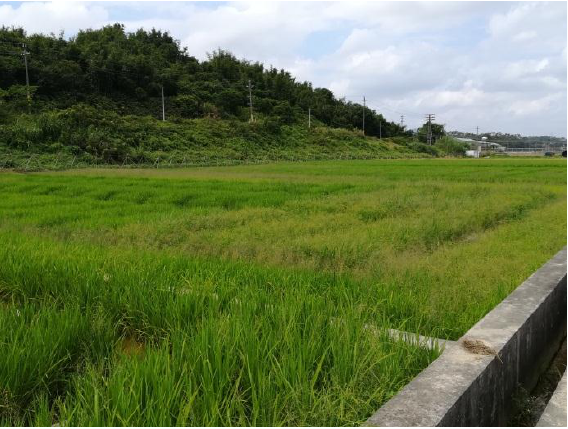
Figure 1. The photograph of the studied rice field.